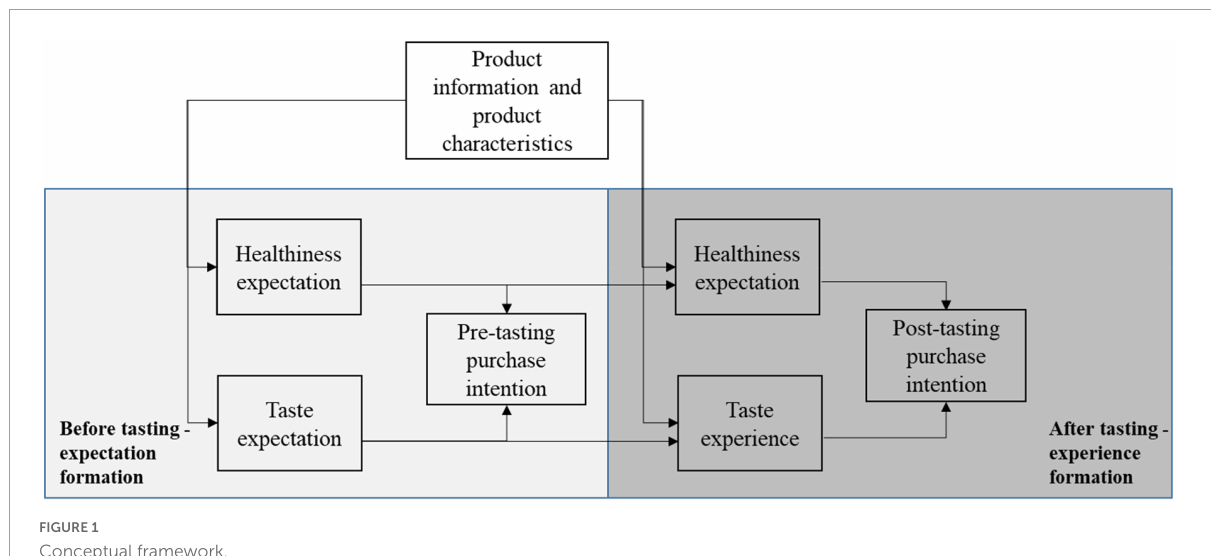
FIGURE1 Conceptual framework.